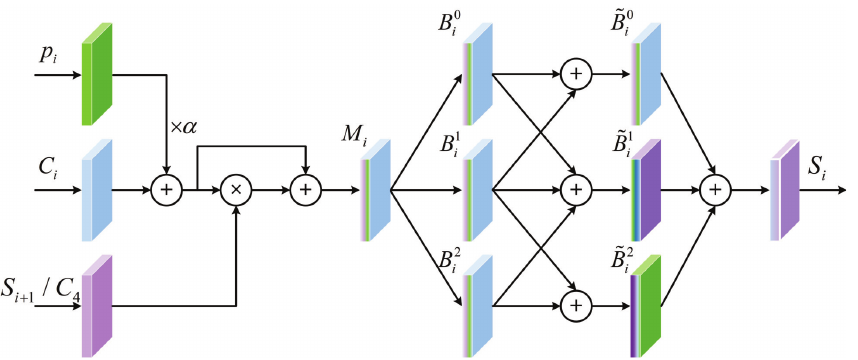
Figure 4. The architecture of the self-multiscale collection